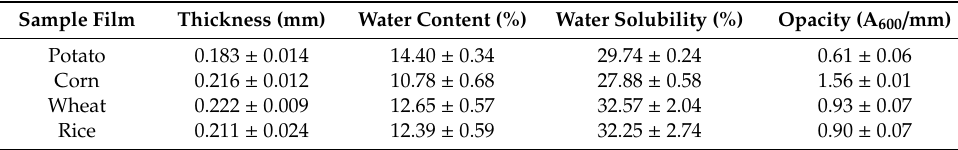
Table 2. Properties of the starch films obtained.